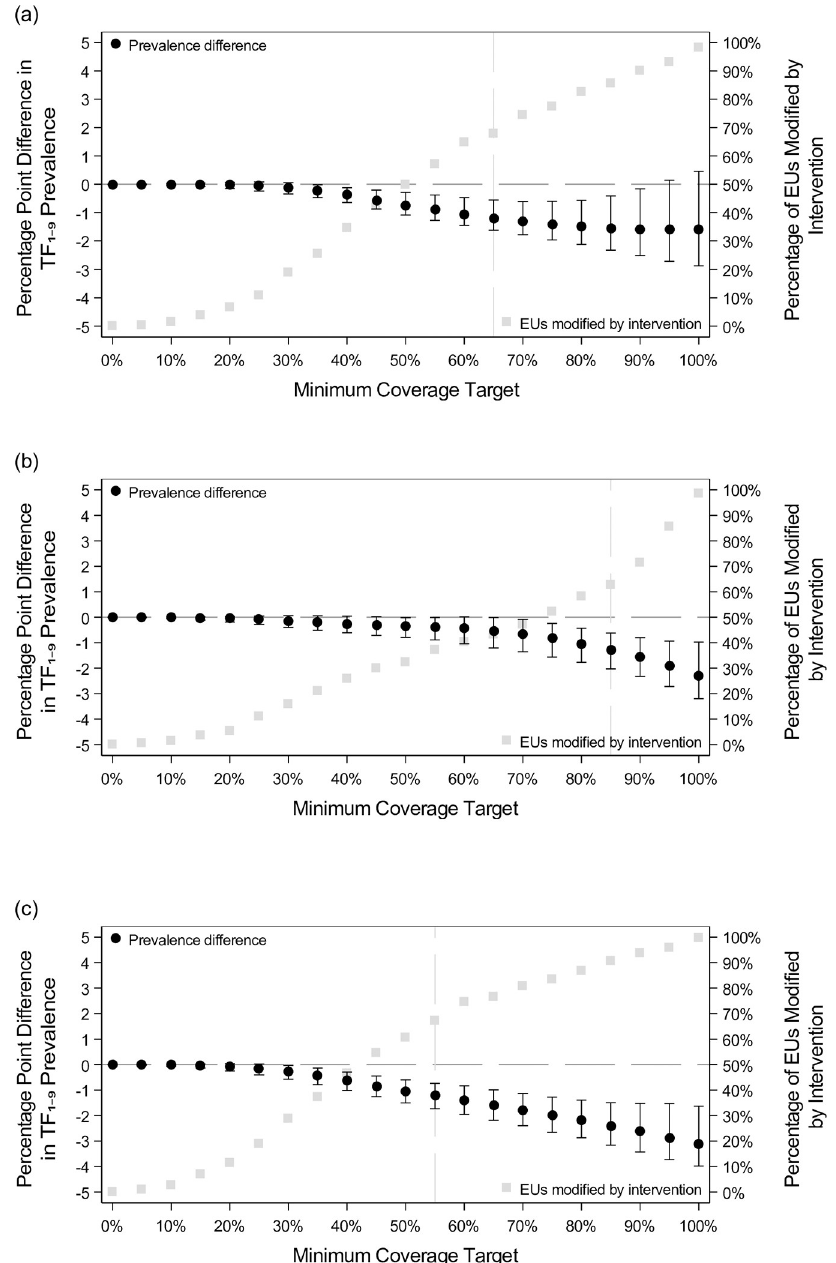
Fig 2. Prevalence difference and number and percentage of EUs modified after implementing hypothetical interventions on nearby face-washing water and latrine coverages among reaching elimination target EUs. These figures show the results presented in Table 2 graphically for (a) nearby face-washing water interventions, (b) latrine interventions, and (c) simultaneous interventions on both nearby face-washing water and latrines for the reaching elimination target EUs. When present, the vertical bar indicates the minimum coverage target at which the relative prevalence decrease was at least 25%.